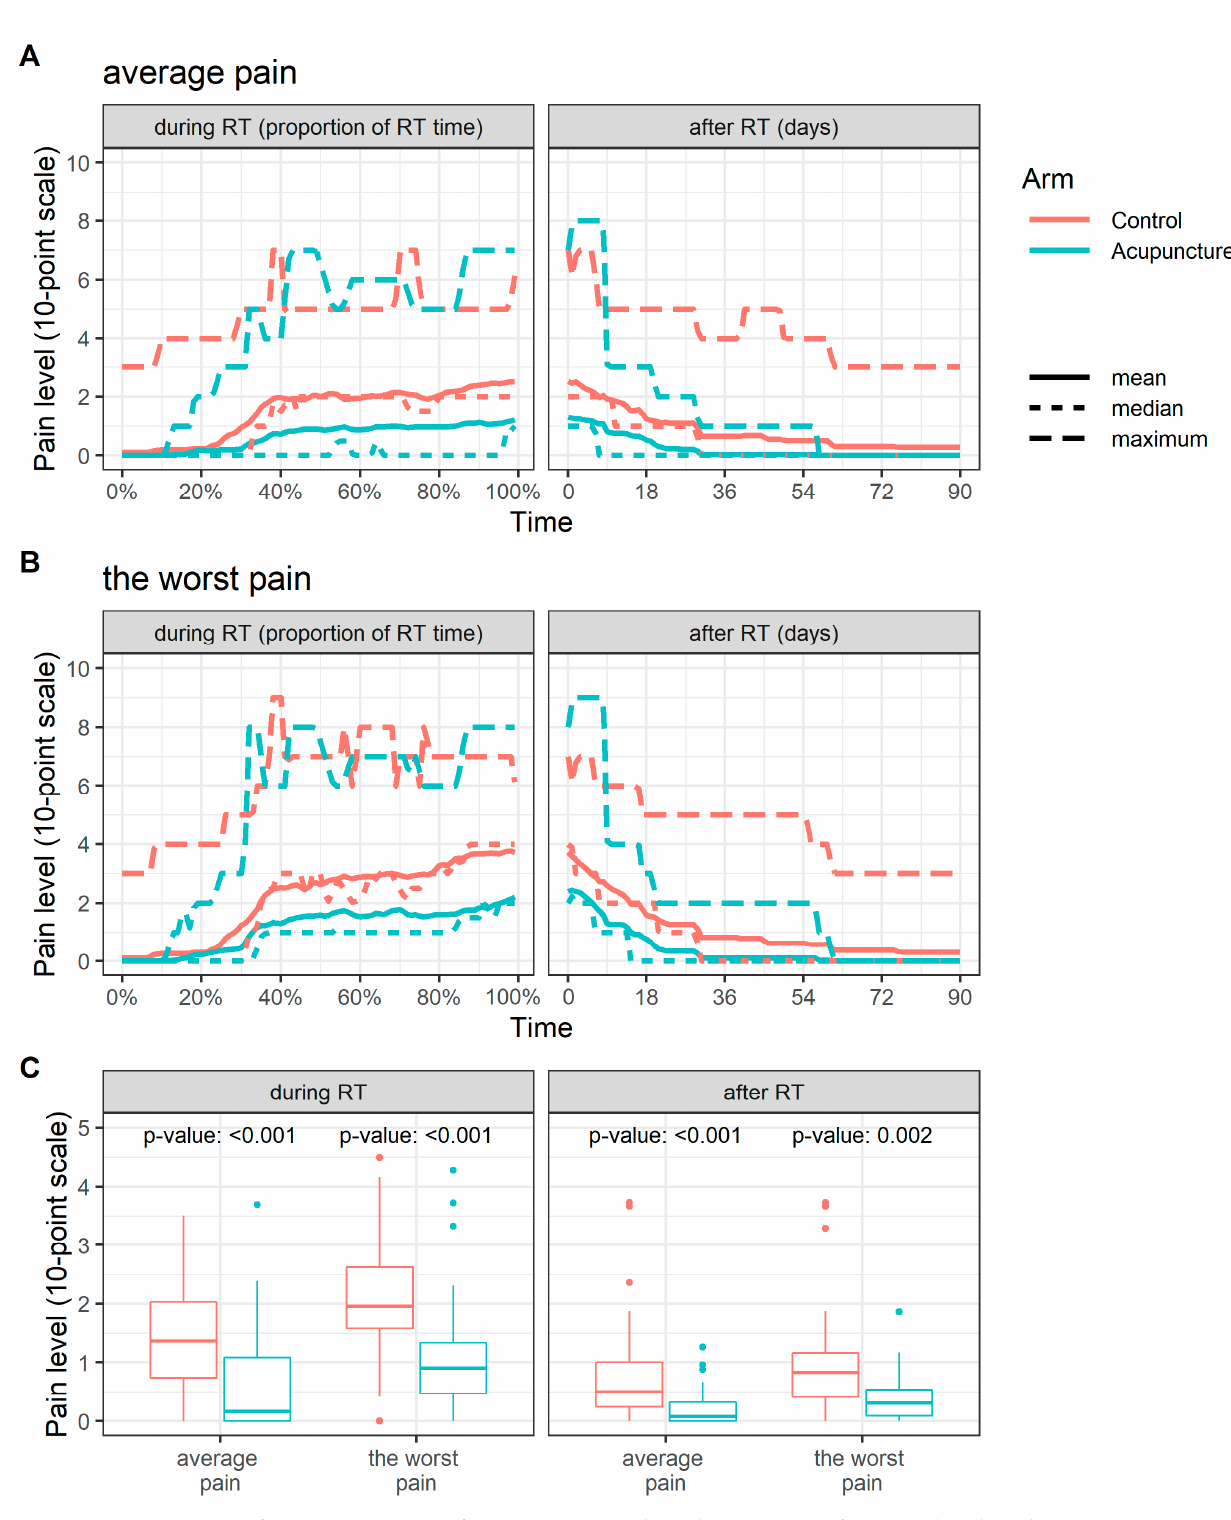
Figure 2. Time course of summary statistics for ( A ) average and ( B ) the worst pain for control (red) and acupuncture (cyan) arm. ( C ) Average pain level per time unit for control (red) and acupuncture (cyan) arm. strate the influence of acupuncture. Specifically, at the start, in the middle, in the three- quarters and at the end of RT, then 14 days after and one month after the end of RT.